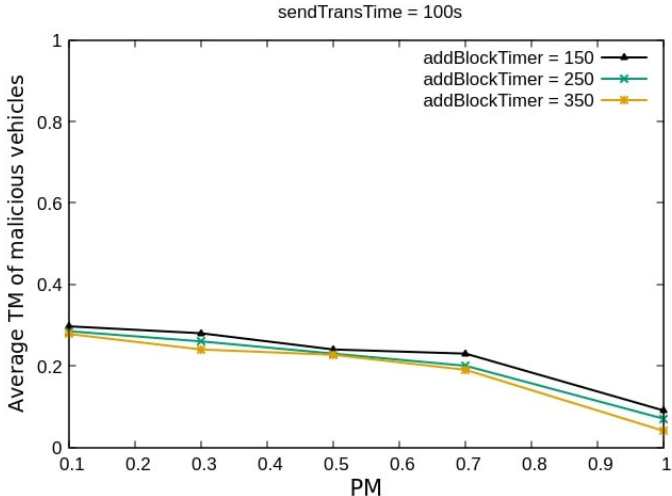
Figure 7 . The average trust metric of malicious vehicles vs. PM, sendTransTimer = 100 s . Figure 7. The average trust metric of malicious vehicles vs. PM, sendTransTimer = 100